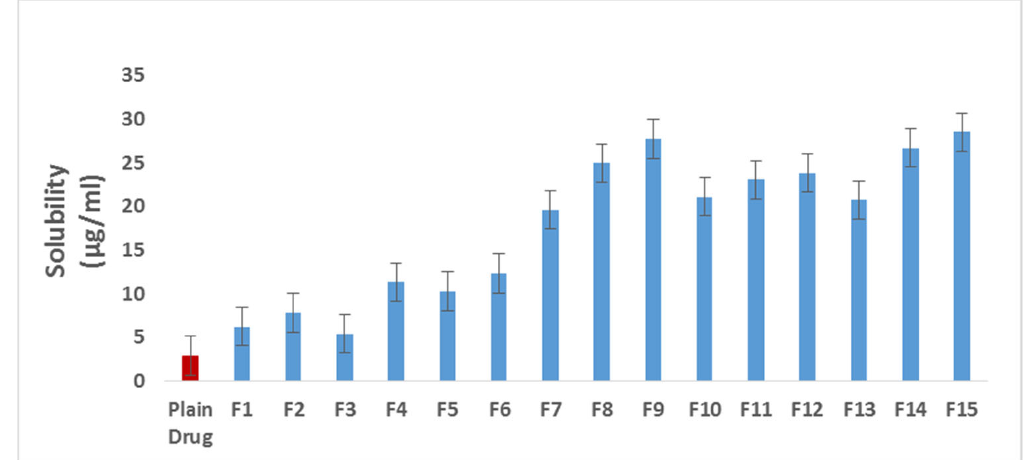
Figure 3. Saturation aqueous solubility of Tel and Tel SSDs.